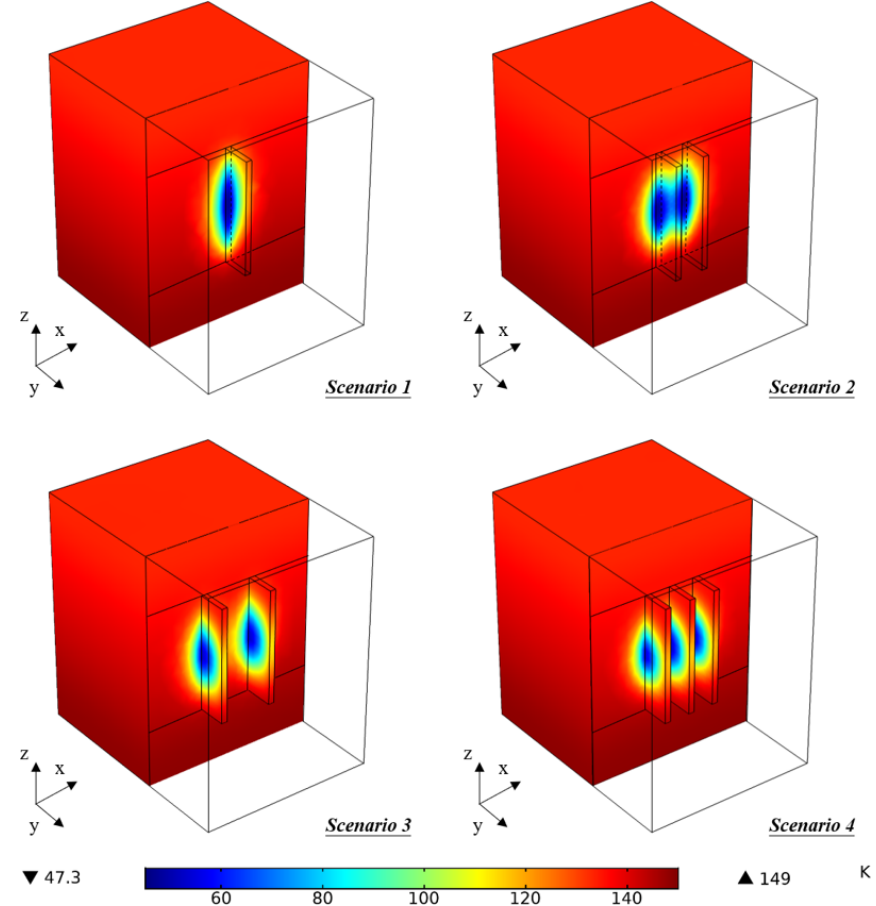
Figure 8. Temperature distribution at 30th year for 4 scenarios.